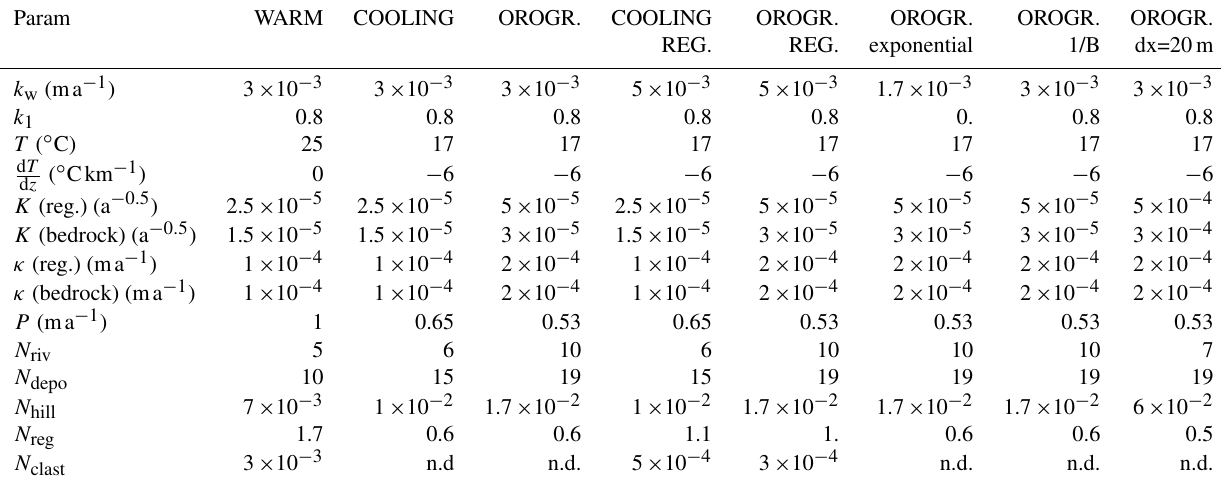
Table 1. Parameters for the main simulations (OROGR. stands for OROGRAPHIC). Other common parameters include the following: U = 1mma − 1 . r = 1mm. E a = 66000Jmol − 1 (albite), 85000 (quartz), and 35000 (biotite). k m = 10 − 12 . 26 molm − 2 s − 1 (albite), 10 − 13 . 39 (quartz), and 10 − 10 . 88 (biotite). V m = 1 . 002 × 10 − 4 m 3 mol − 1 (albite), 2 . 269 × 10 − 4 (quartz), and 1 . 5487 × 10 − 4 (biotite). S c = 0 . 84. k 1 = 0 . 8. d 1 = 0 . 5m. d 2 = 0 . 1m. For experiments with lateral erosion α = 1 × 10 − 3 for loose material except in “OROGRAPHIC_dx=20m” where α = 5 × 10 − 3 . ξ = 0 . 1am − 1 . The values of P and T , as well as the non-dimensional numbers, are given for z = 0m at the end of the simulation. n.d.: not